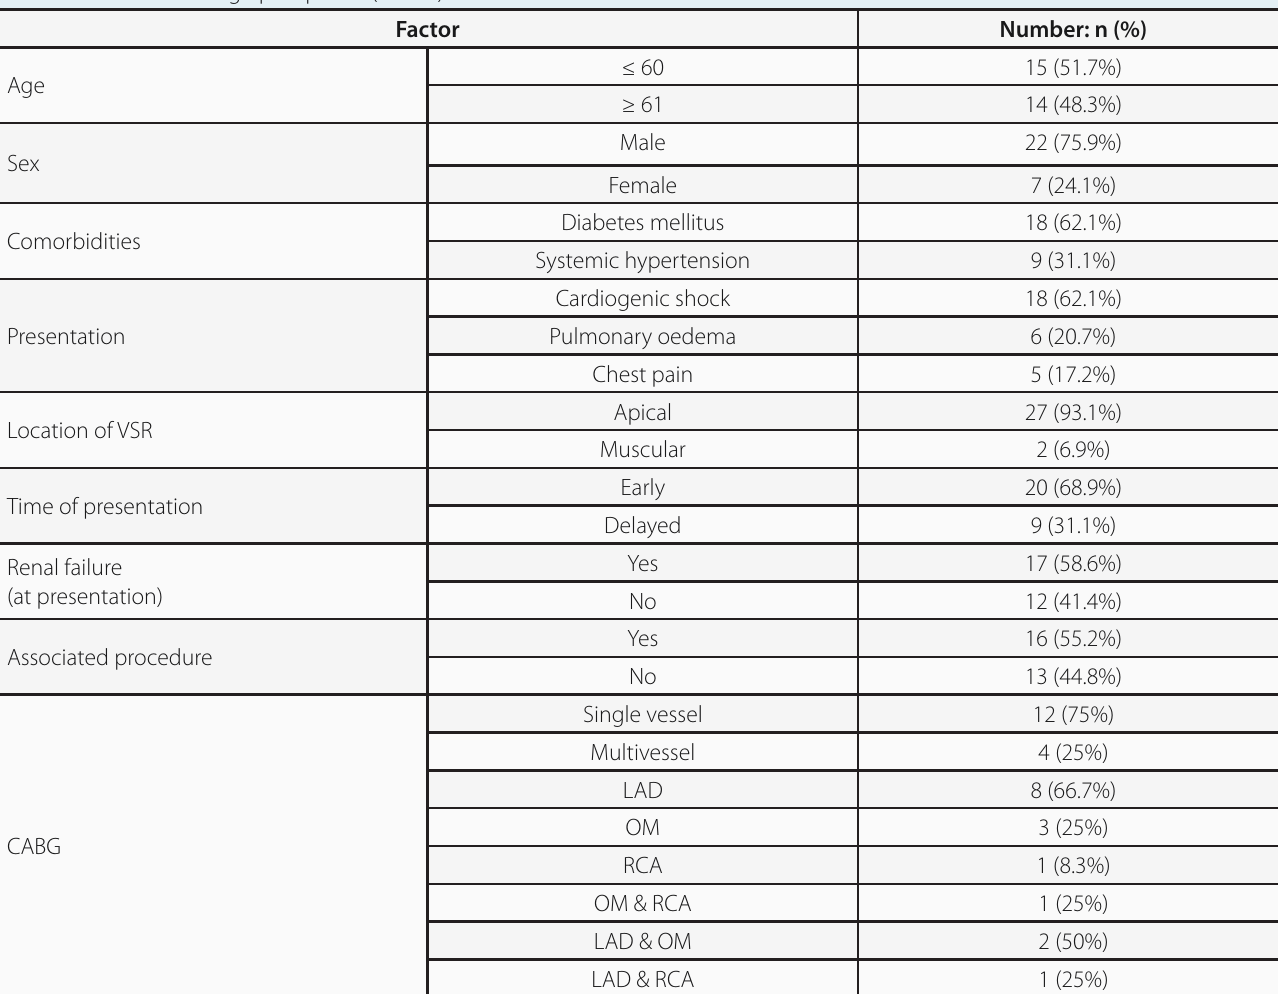
Table 2. Patients’ demographic profile (n = 29).